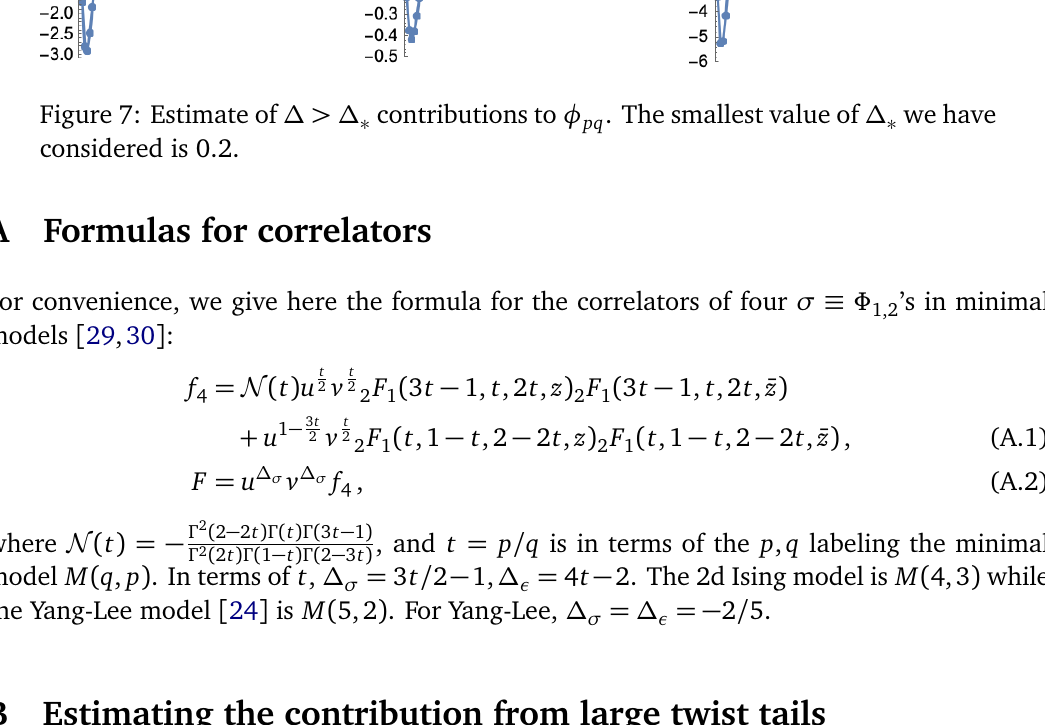
. The smallest value of ∆ ∗ we have pq